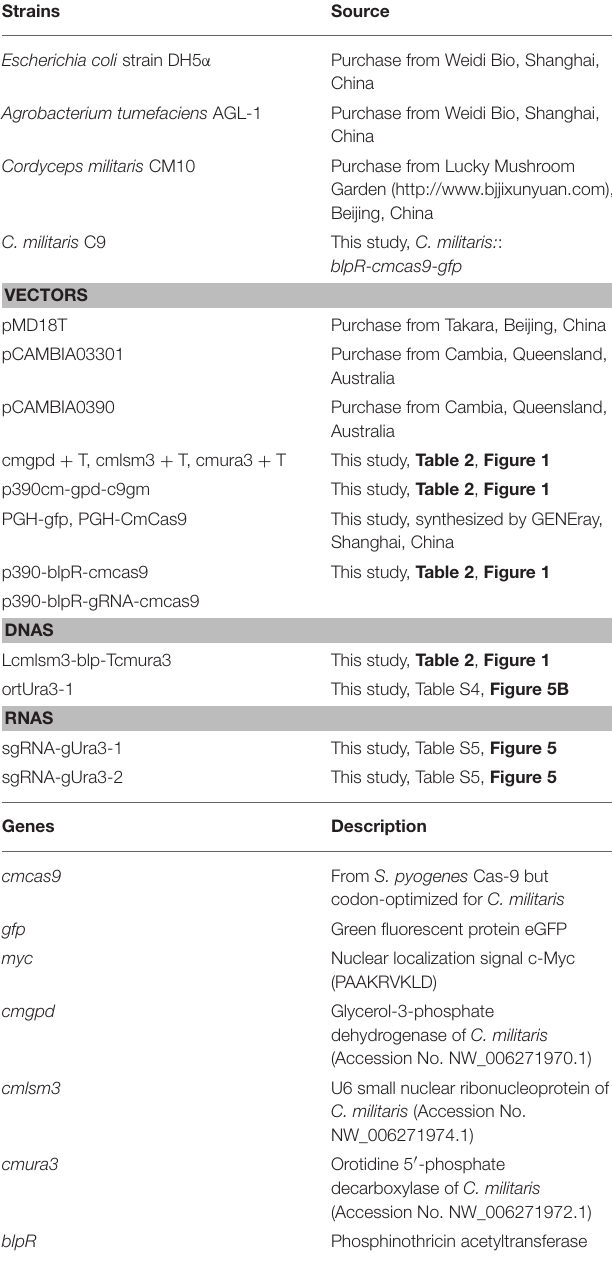
TABLE 1 | Materials of strains and nucleic